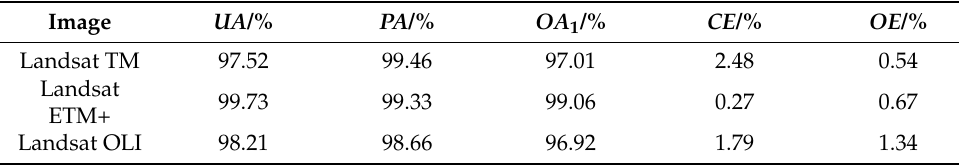
Table 6. Accuracy of the results in study area 4 using the proposed